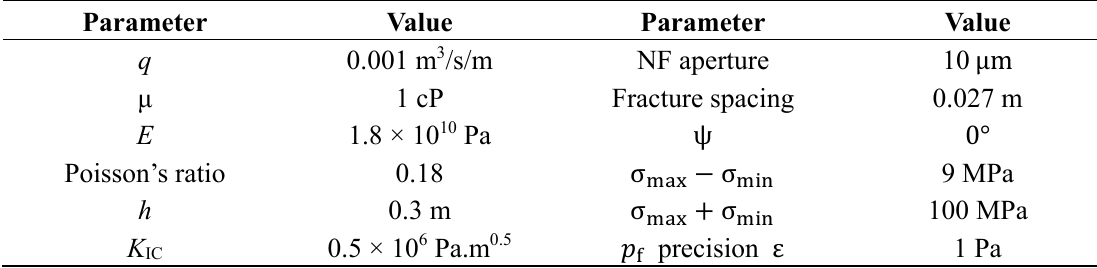
Figure 8. The numerical setting. Table 4. The default values of the input